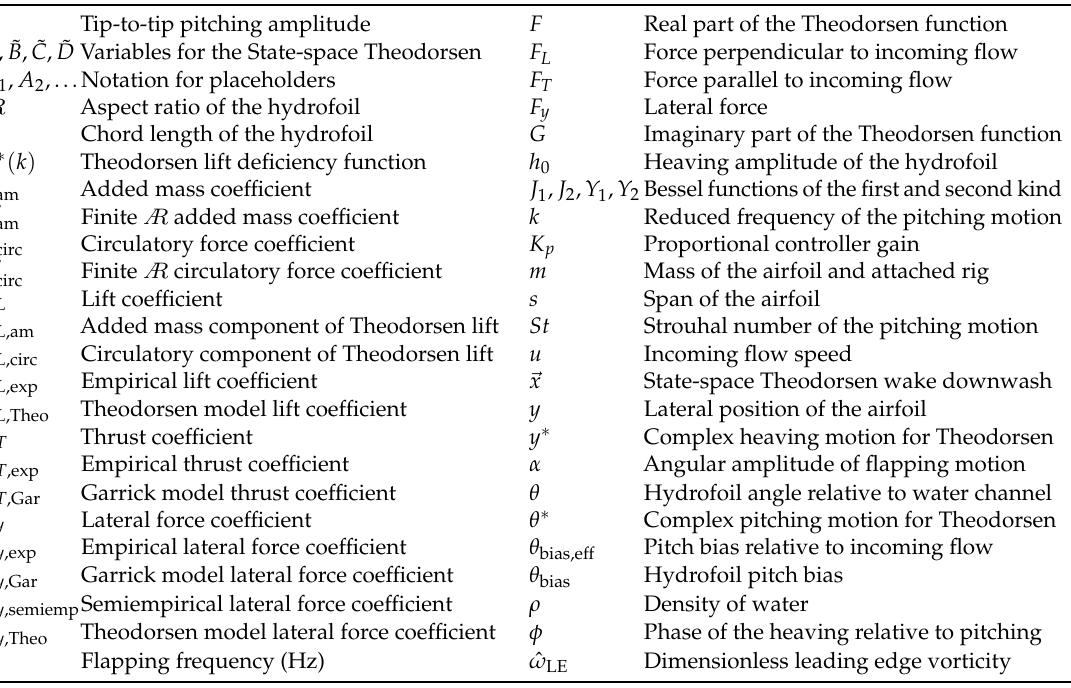
Table 1. Variable